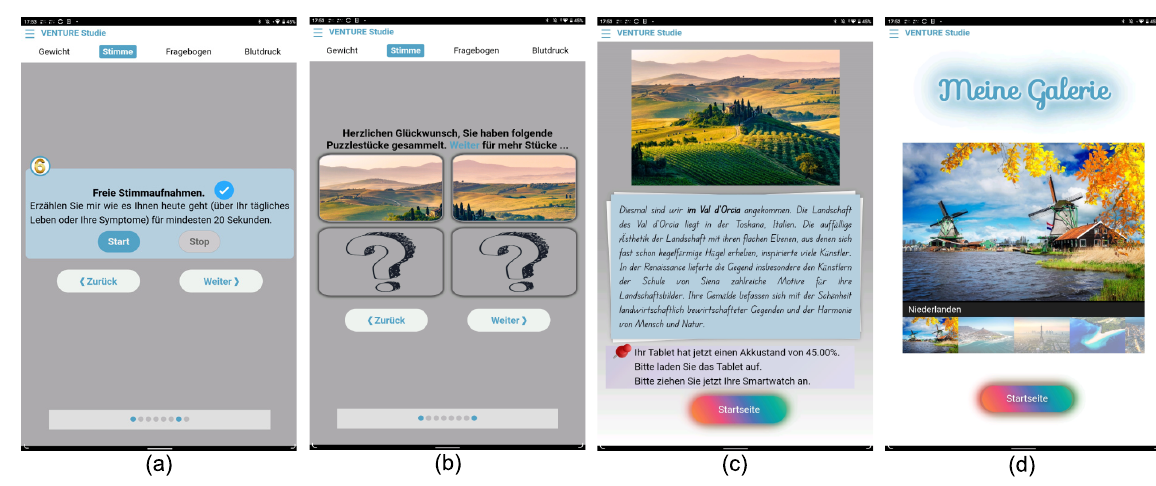
Fig 3. Four screenshots of the study application. (a) A screenshot of the voice recording procedure. (b) The participant obtains two pieces of the image after finishing two measurement sections. (c) After completing the measurement, the participant obtains a new image and its description as a reward. (d) The participant can view all collected images in the